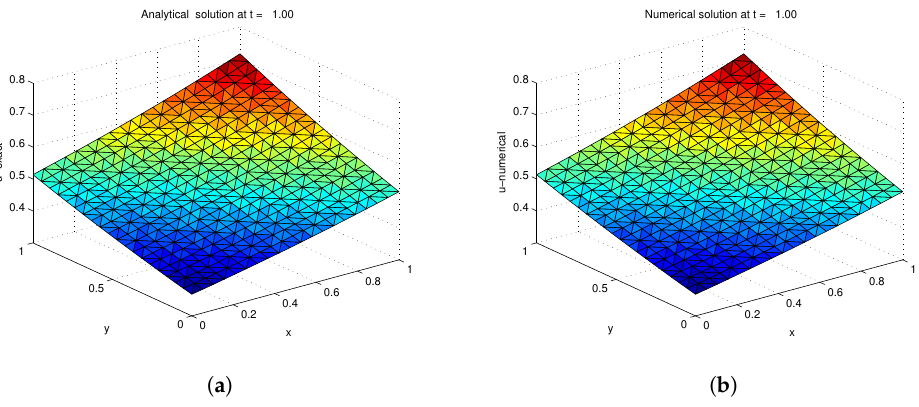
Figure 4. ( a ) Exact against ( b ) numerical solutions, when t = 1, δ t = 0.0001, ns = 20, M = 400, corresponding to Example